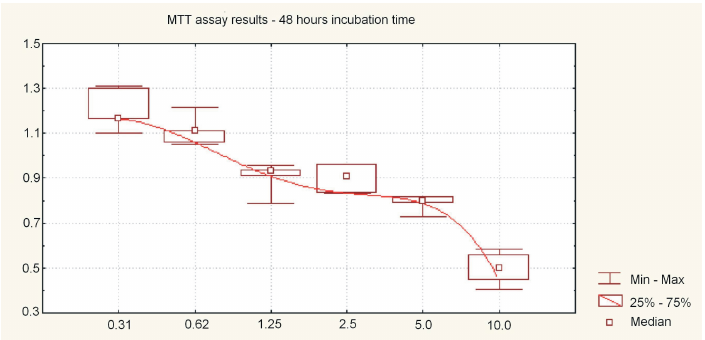
Figure 4. MTT assay results after 48 h of cell culture incubation representing absorbance values (median, min-max) for different dispersed Ag-NP concentrations (0.31 μ g/mL to 10 μ g/mL). Like after 24 h incubation time, AgNPs also inhibited the growth in a dose-dependent manner, with a highly significant variation of MTT absorbance values compared to the 24 h protocol. A “flattened” viability curve between the concentrations of 1.5 and 5 µ g/mL of AgNP could be an effect of the experimental conditions. Differences of mean absorbance values between different AgNPs concentrations were highly significant ( p < 0.01, ANOVA Friedman ANOVA